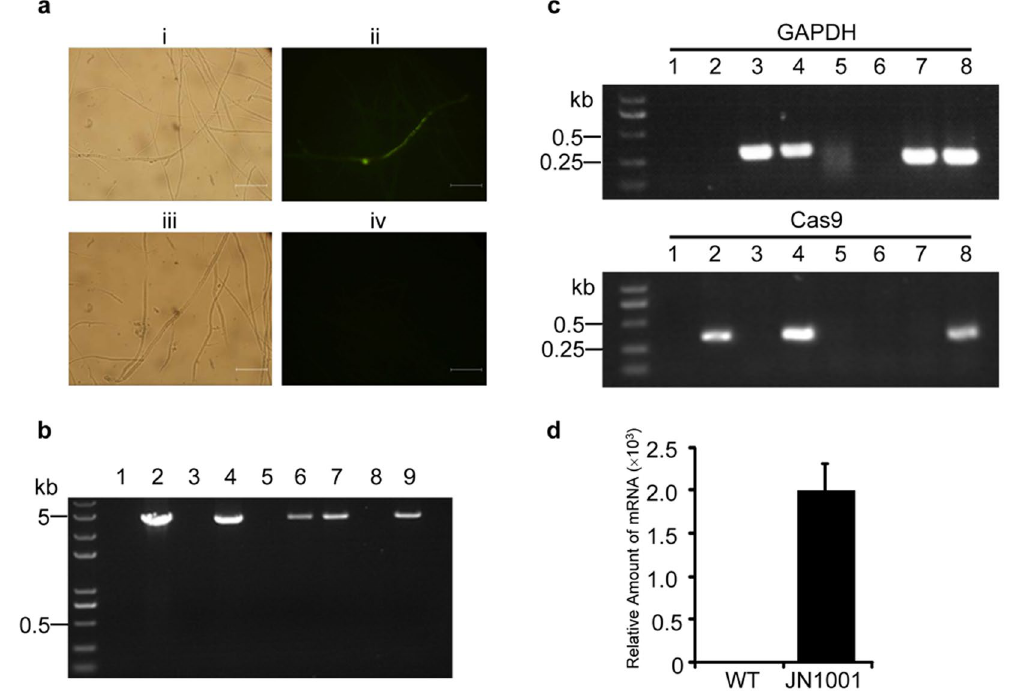
Figure 2. Establishment of the Cas9 stable expression Nodulisporium sp . (No. 65-12-7-1). ( a ) Analysis of the Cas9-eGFP expression in the mycelia transfected with pDHt/sk-Ppdc- toCas9 - eGFP -Tpdc (i, ii) and wild-type (iii, iv). The bar represents 100 μ m. ( b ) Analysis of the integration of cas9 gene into the genome. (lane 1: wild- type; lane 2: pBSKII- tocas9 - hph ; lane 3: JN1002; lane 4: JN1001; lane 5: JN1003; lane 6: JN1004; lane 7: JN1005; lane 8: JN1006; lane 9: JN1007). ( c ) RT-PCR analysis of the Cas9 expression. Upper panel for GAPDH and lower panel for Cas9. lane 1: H 2 O; lane 2: pBSKII- toCas9 - hph ; lane 3: genomic DNA of wild-type; lane 4: genomic DNA of JN1001; lane 5: RNA of wild-type; lane 6: RNA of JN1001; lane 7: cDNA of wild-type; lane 8: cDNA of JN1001. ( d ) Real-time PCR quantitative analysis of Cas9 expression in WT and